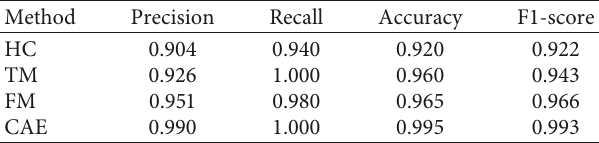
Table 2: Inspection results between CAE and image similarity comparison